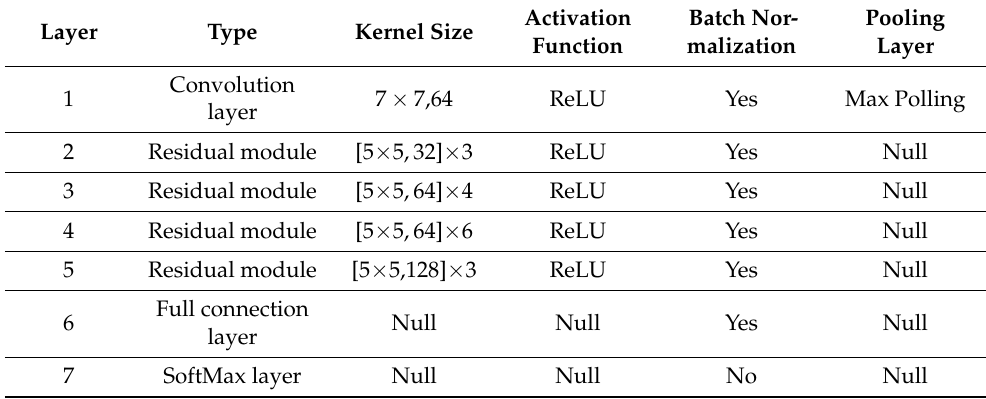
Table 2. Parameters of pre-training